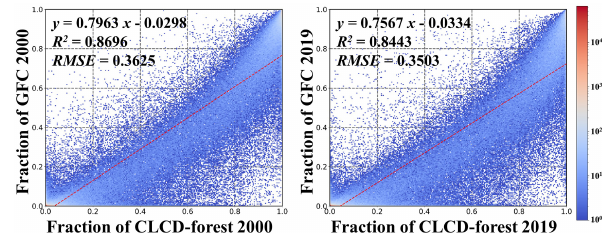
Figure 8. Scatterplots of forest fraction between the CLCD and GFC in 2000 and 2019. Forest fraction was aggregated within the 0.05 ◦ by 0.05 ◦ spatial